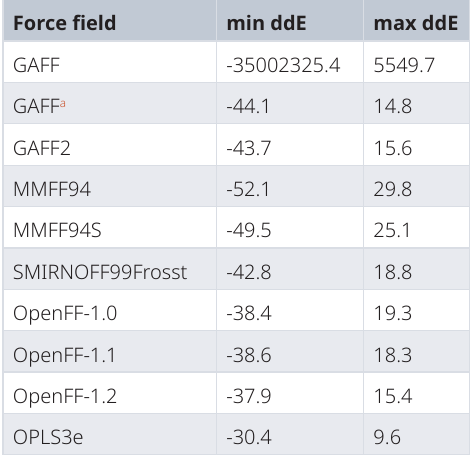
Table 1. Minimum and maximum ddE values as computed in Equation 2 for all structures of each force field. Energy units are in